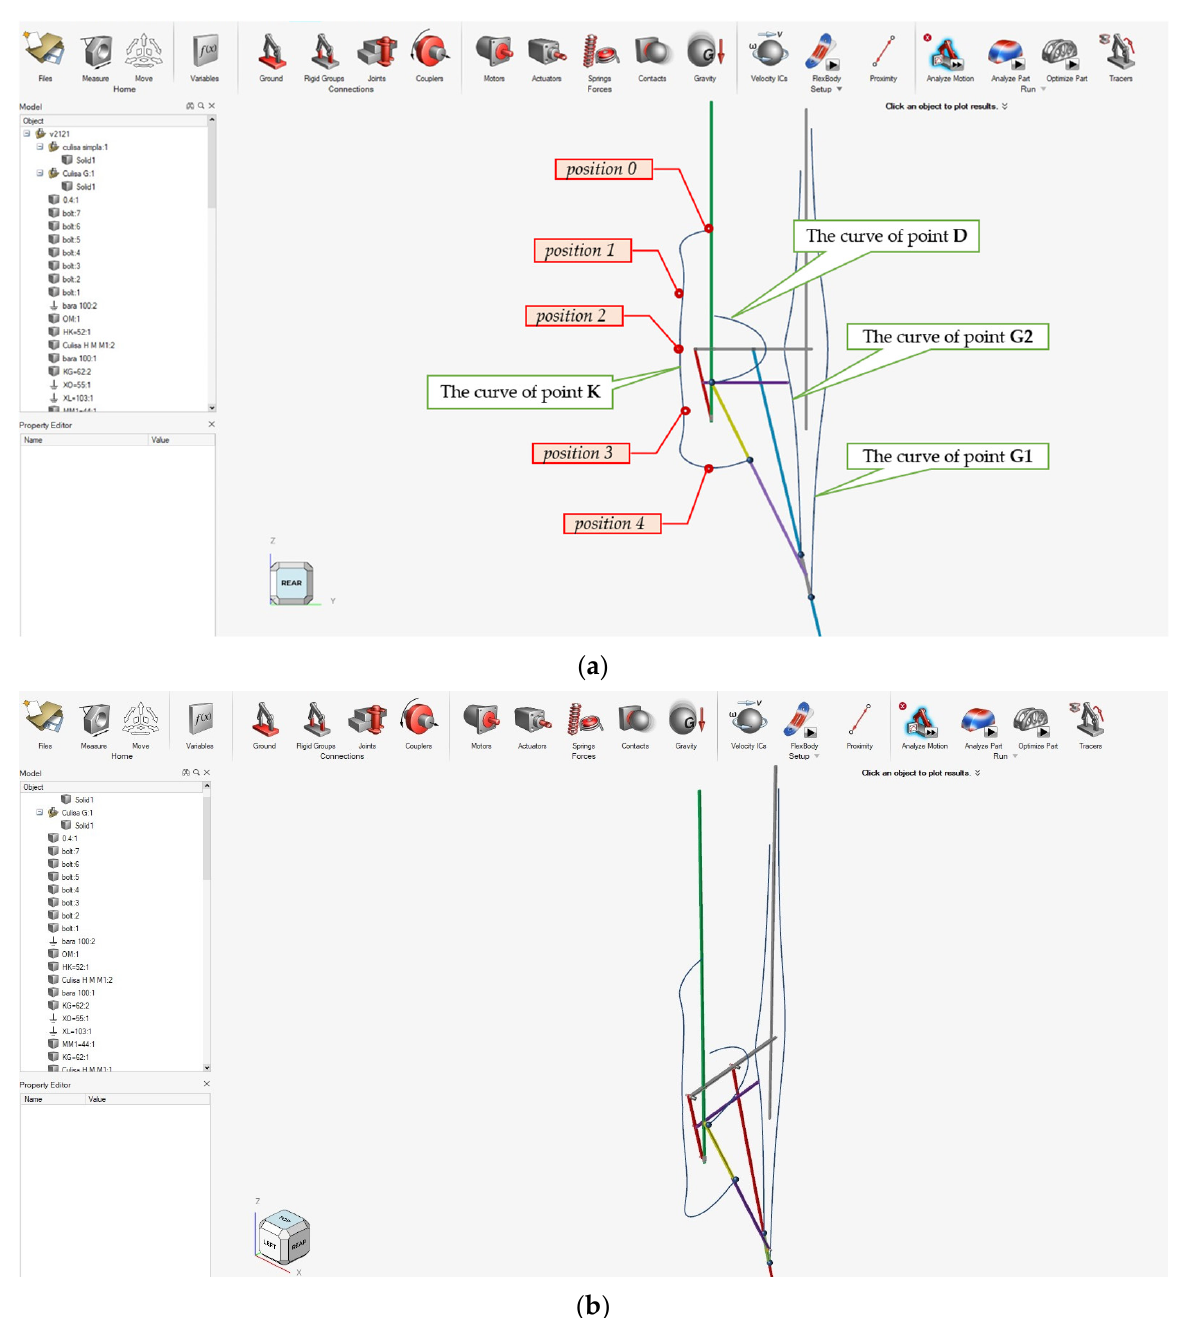
Figure 22. The mechanism and the obtained curves: ( a ) plan view; ( b ) axonometric view. Figure 23a shows the mechanism during operation in five successive positions, and Figure 23b highlights one of the critical positions, when elements no. 1, 6, 7, 9, and 10 are